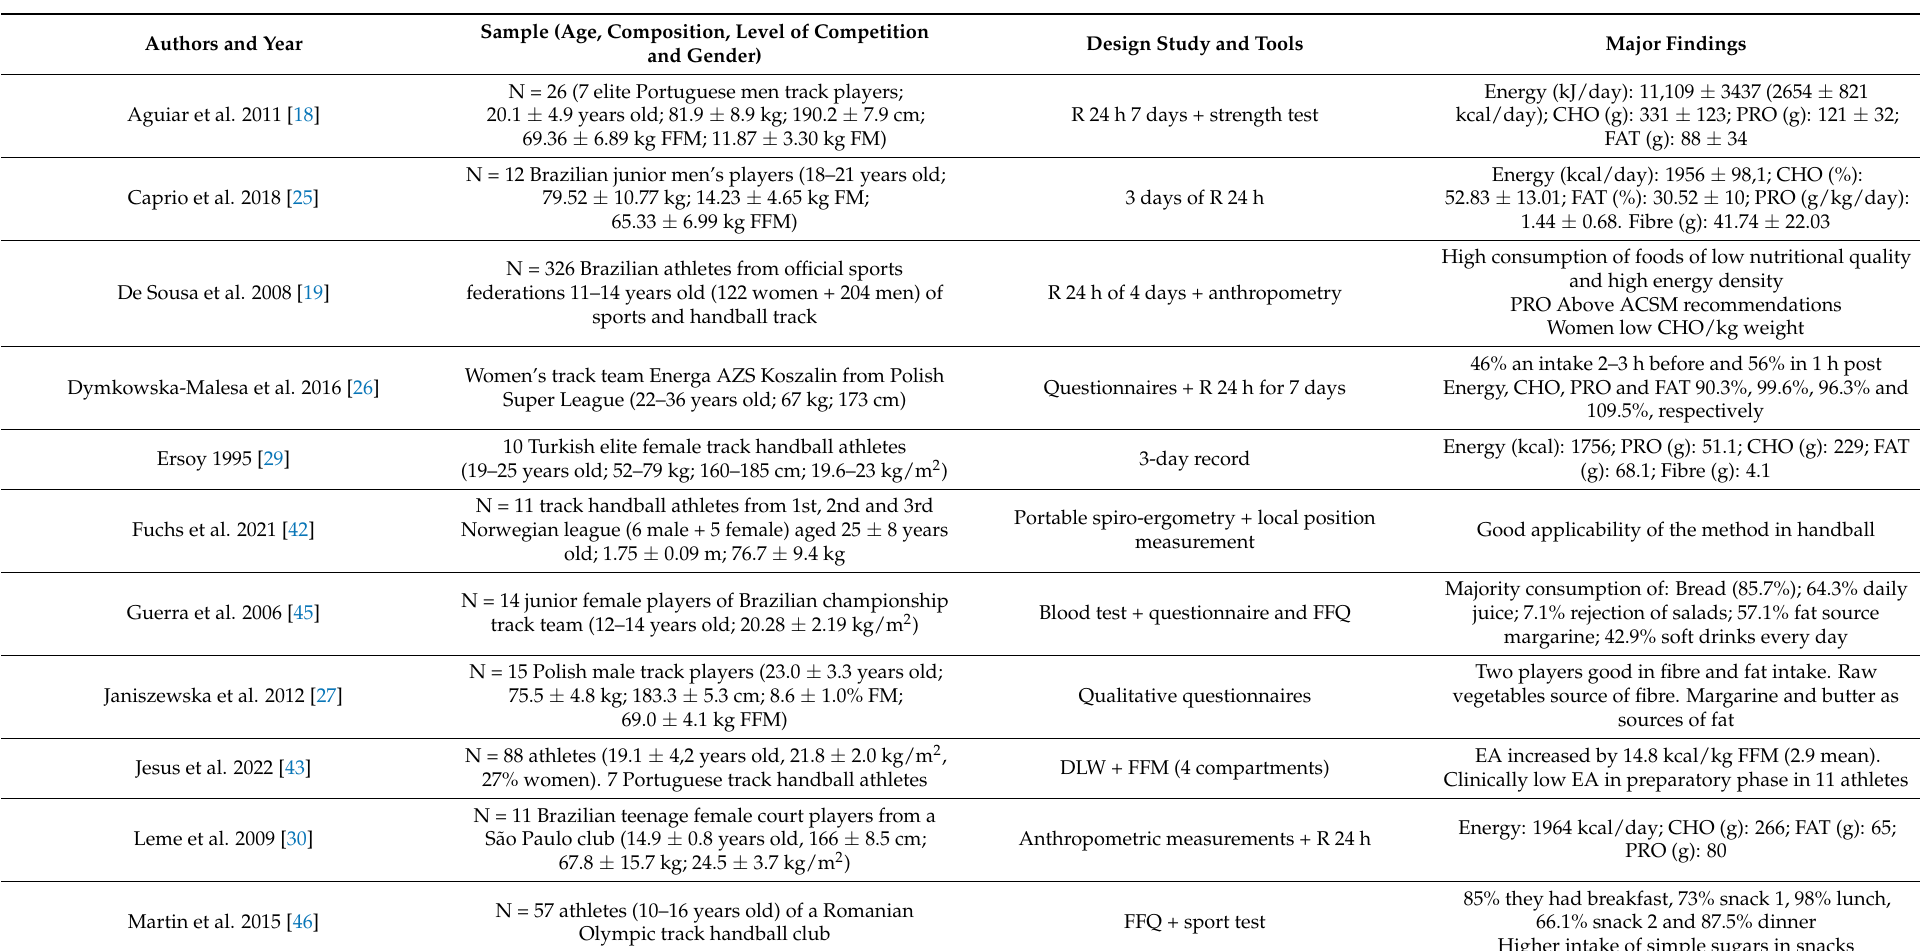
Table 2. Intake and requirements of energy, macronutrients and fibre. Frequency of consumption by food